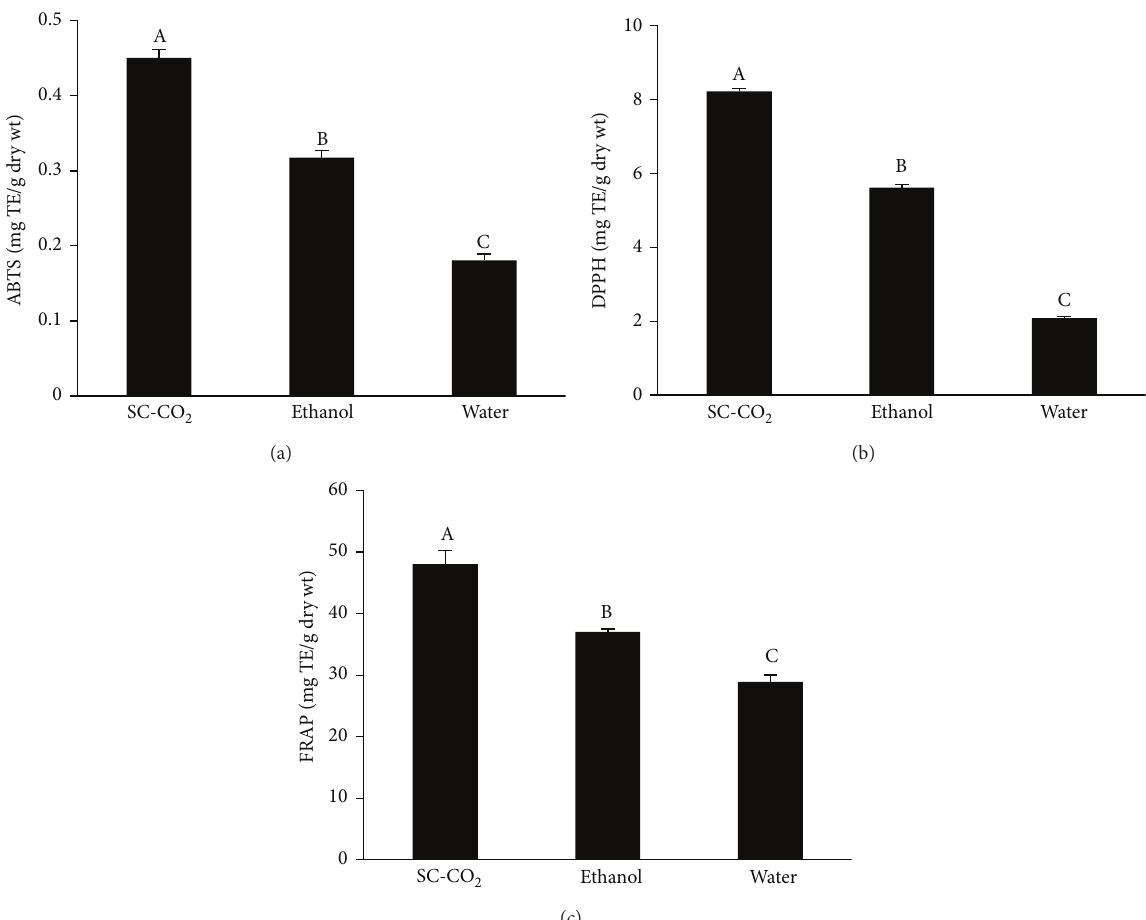
Figure 2: Effects of SC-CO 2 extraction on antioxidant activity of Antidesma thwaitesianum as assessed by (a) ABTS, (b) DPPH, and (c) FRAP. Values are mean ± SD ( 𝑛 = 3 ). TE, trolox equivalent. Means with different letters (A–C) are significantly different ( 𝑃 < 0.05